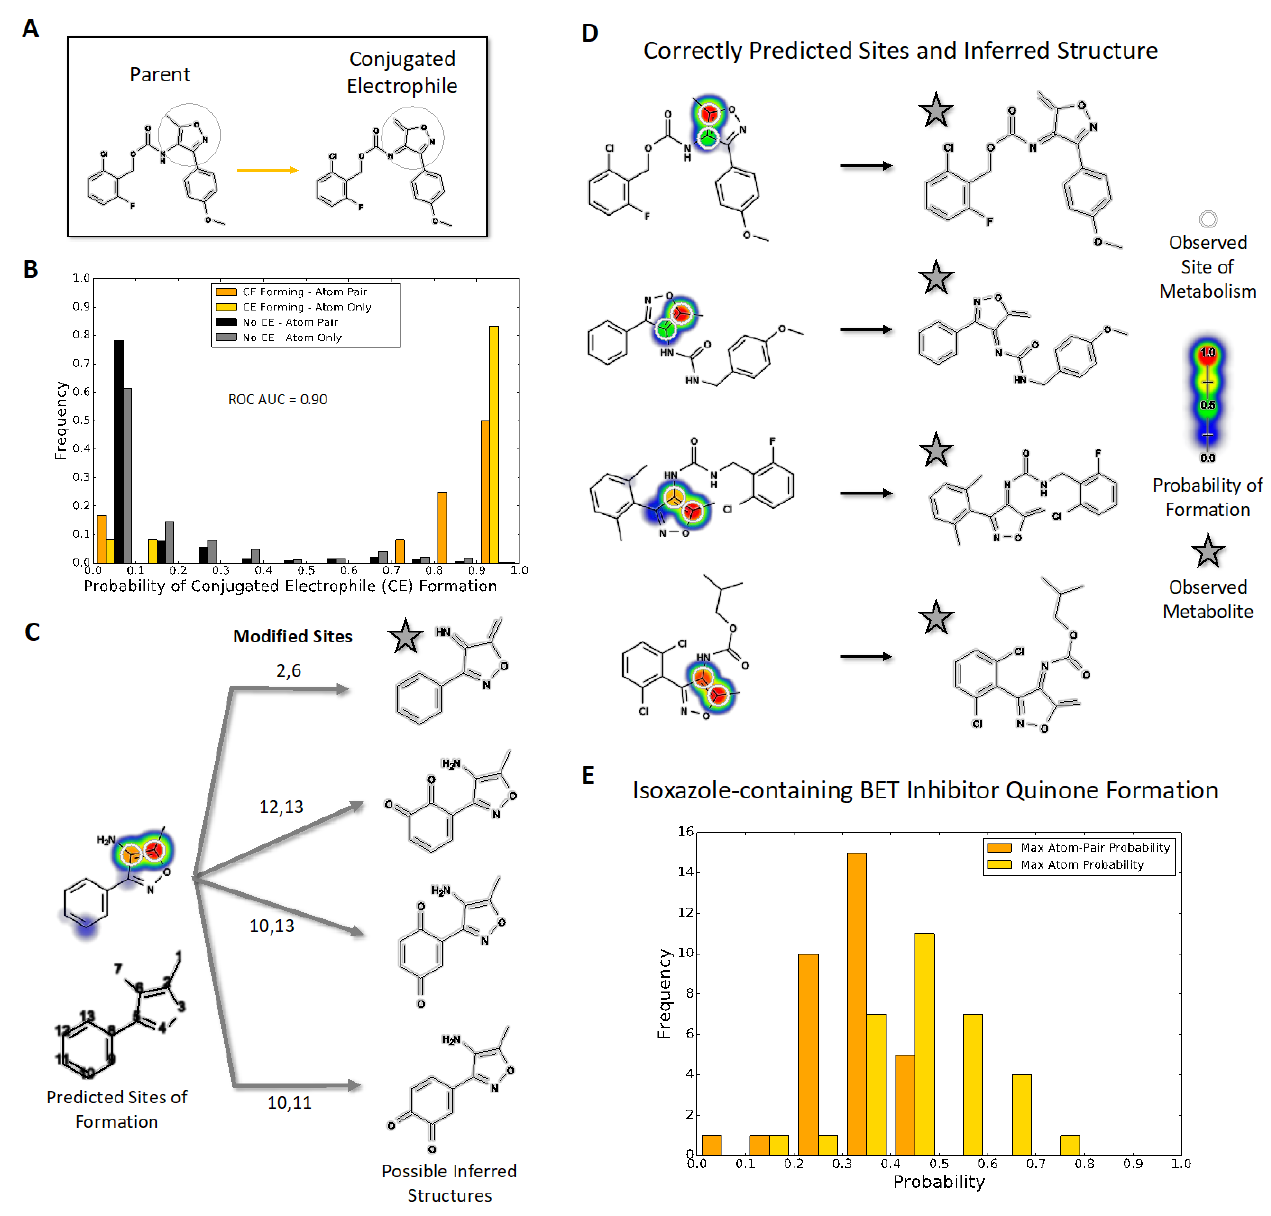
Figure 1. Quinone model predictions for bioactivation of isoxazole-containing molecules ( A ) Compounds with an isoxazole ring, shaded in grey, can be metabolized into reactive electrophiles such as the illustrated enimine. ( B ) The quinone model identifies which isoxazole-containing molecules will undergo bioactivation into a conjugated electrophile involving the isoxazole ring with 90% AUC accuracy. The histogram uses normalized frequencies; therefore, the scale is balanced for the 332 negative (not bioactivated) molecule predictions and the 12 positive (bioactivated) molecule predictions. ( C ) The quinone structure inference model can generate possible quinone and enimine metabolite structures for a queried compound. ( D ) For all 10 enimine-forming molecules, the quinone structure inference model correctly predicts the reported metabolite structure when using the highest atom-pair probability. ( E ) Likelihood of conjugated electrophile formation among drug leads for bromodomains, predicted using the quinone model with two types of assessment (see